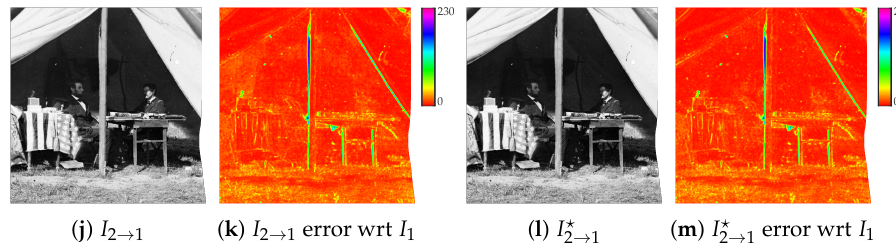
Figure 2. Auxiliary image pointwise transfer and color correction steps (see Sections 2.1 and 2.2): ( a ) Reference image I 1 , ( b ) auxiliary image I 2 , ( c ) superimposition of I 1 and I 2 as anaglyph, ( d ) visual representation of the optical flow map ( m x , m y ) extracted by RAFT, ( e ) image ˜ I 2 → 1 as resynthesis of I 2 through ( m x , m y ) and ( f ) its error with respect to I 1 , ( g ) visual representation of the optical flow map ( m (cid:48) x , m (cid:48) y ) extracted by RAFT after switching the input images, ( h ) image ˜ I 2 → 1 as resynthesis from I 2 through − ( m (cid:48) x , m (cid:48) y ) and ( i ) its error with respect to I 1 , ( j ) final resynthesized image I 2 → 1 ( x , y ) and ( k ) its error considering the locally best optical flow estimation between ˜ I 2 → 1 ( x , y ) and ˜ I (cid:48) 2 → 1 with respect to I 1 , ( l ) image I (cid:63) obtained after applying GPS/LCP color correction to I 2 → 1 using I 1 2 → 1 as reference, and ( m ) the corresponding error map with respect to I 1 . Best viewed in color. The reader is invited to zoom into the electronic version of the manuscript in order to better appreciate the visual